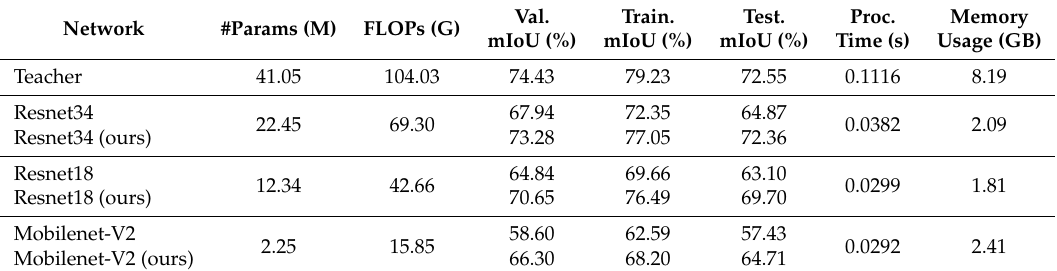
Table 4. Effects of our distillation method for various student networks on the Cityscapes dataset.